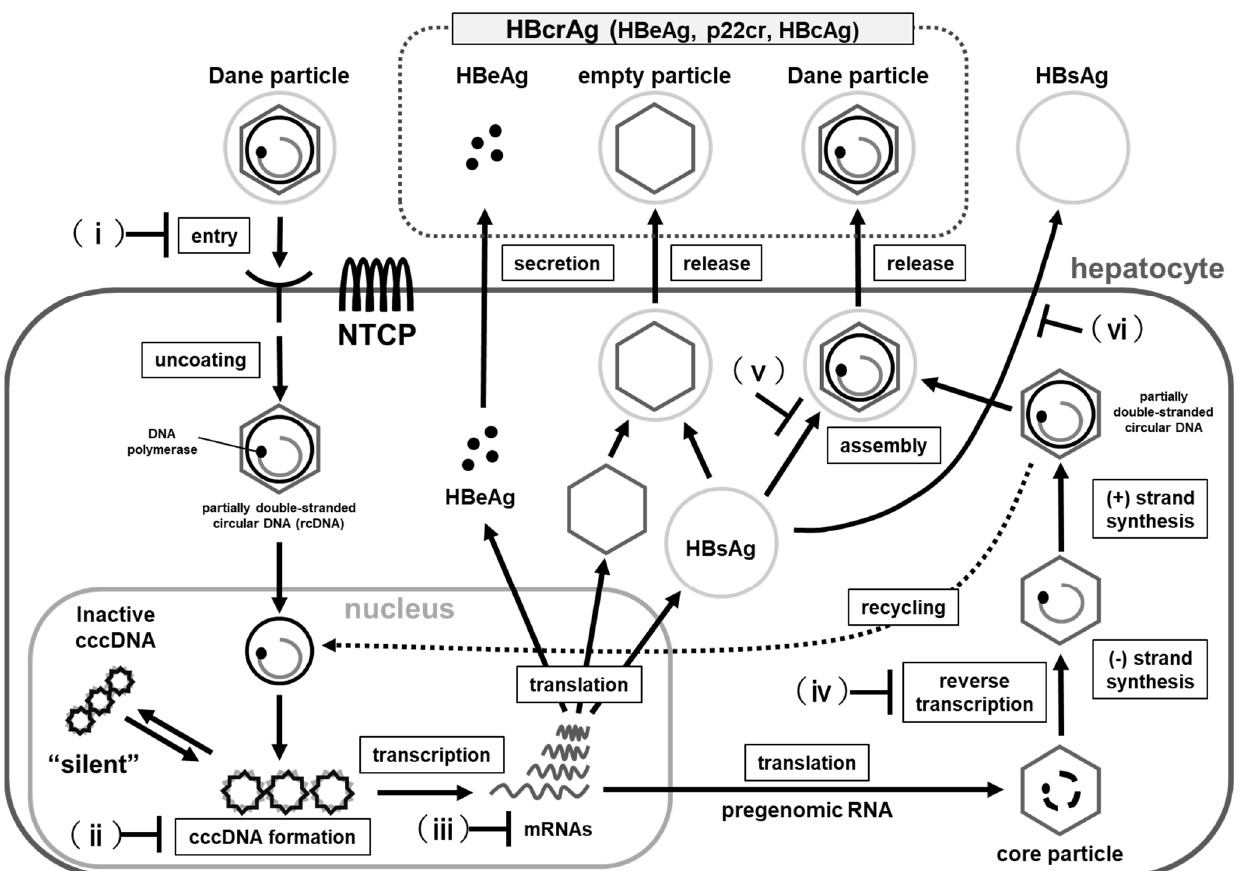
Figure 1. Life cycle of HBV and therapeutic agents. ( i ) Inhibition of HBV entry into hepatocytes, ( ii ) Targeting cccDNA, ( iii ) Targeting viral transcripts, ( iv ) Inhibition of reverse transcription, ( v ) Inhibition of capsid formation or nucleocapsid assembly, ( vi ) HBsAg Inhibitors.